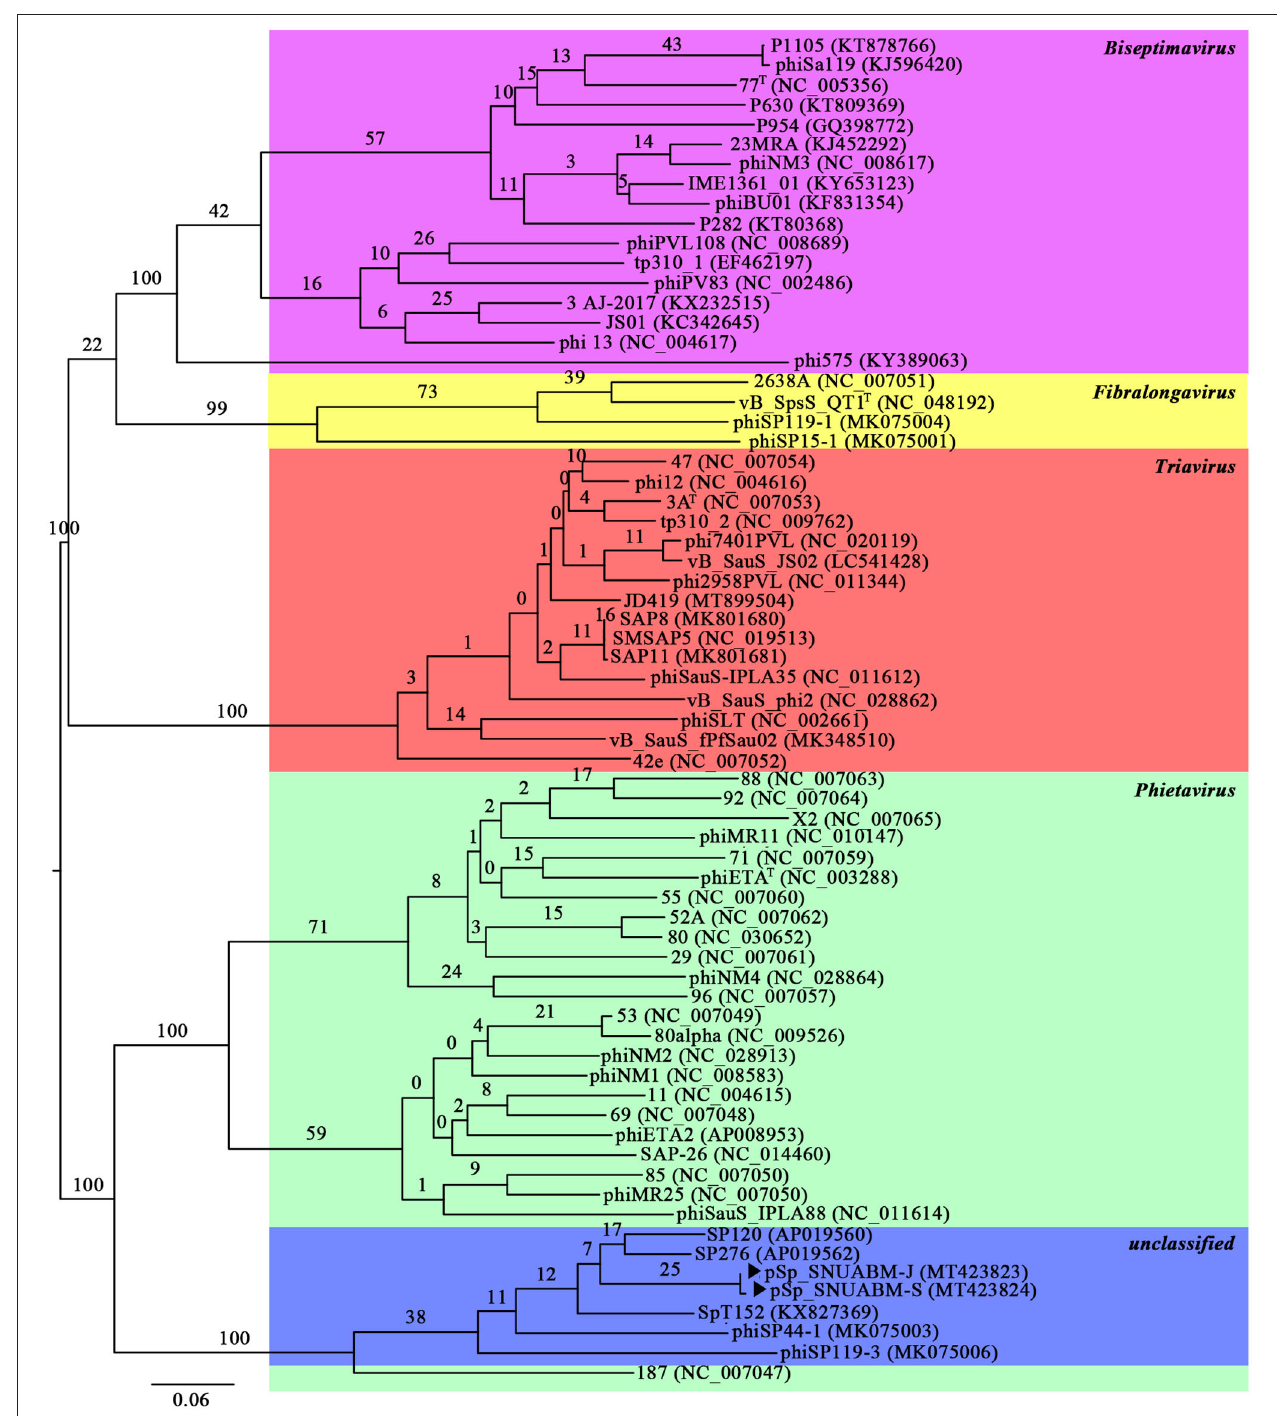
FIGURE 8 | The phylogenetic analysis of the phage pSp-J, and pSp-S. The tree was constructed using VICTOR with recommended settings for phages (prokaryotic viruses). The clusters of phages are colored in green ( Phietavirus ), blue (unclassified), purple ( Biseptimavirus ), yellow ( Fibralongavirus ), and red ( Triavirus ).